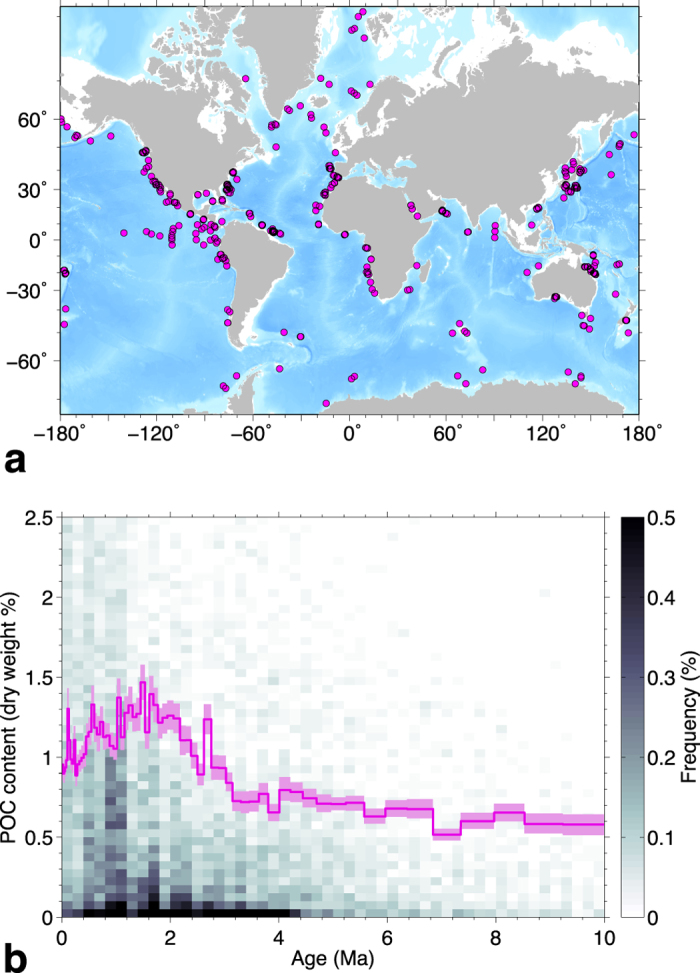
Drill sites in regions of high POC deposition.Location of 419 sites (a) and POC content as a function of sediment age (b). The background image in (b) is a two-dimensional histogram of 16923 data points showing the broad range of measured POC values at various ages. The continuous curve in (b) is the average POC calculated in age intervals that contain the same number of data points (~250). This procedure ensures that the POC averages are not affected by a variable number of data points in each age interval. The colored band around the average in (b) is a measure of uncertainty (68% central interval in bootstrap resampling; see Methods). The map in (a) was produced with the Generic Mapping Tools (GMT) package59.